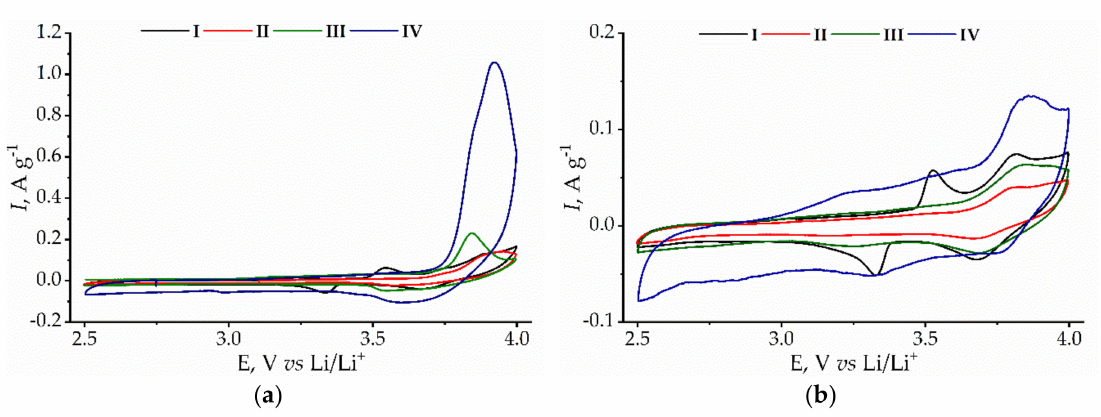
Figure 3. Cyclic voltammetry (CV) of I – IV ( a ) before galvanostatic charge–discharge (GCD); ( b ) after the last GCD cycle; rate 0.05 mV / s, 1M LiPF 6 in 1:1:1